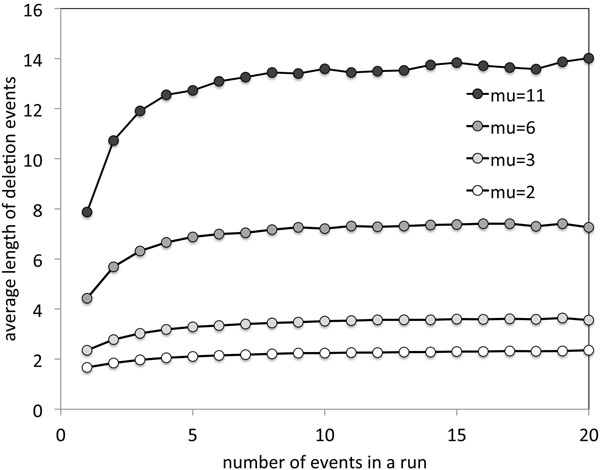
Non-independence of deletion events in a run Association of shorter deletions with smaller values of r.